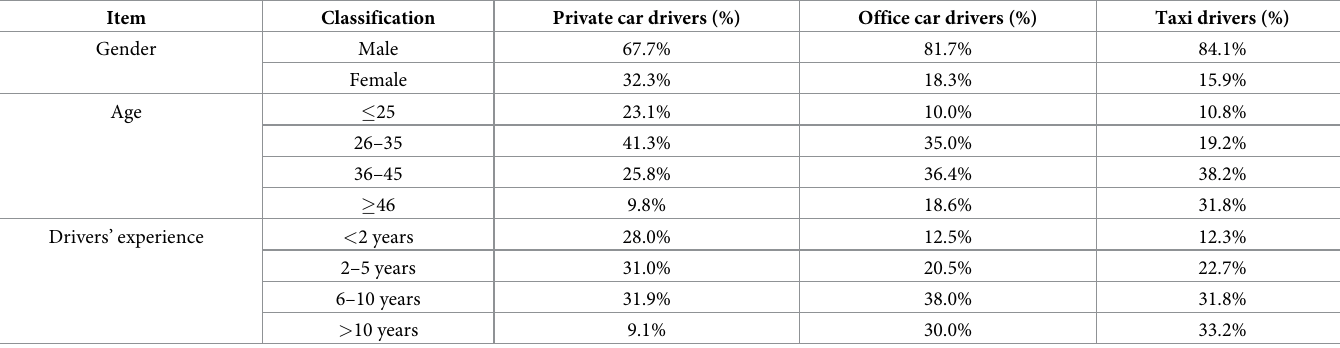
Table 3. Descriptive statistics of socio-demographic